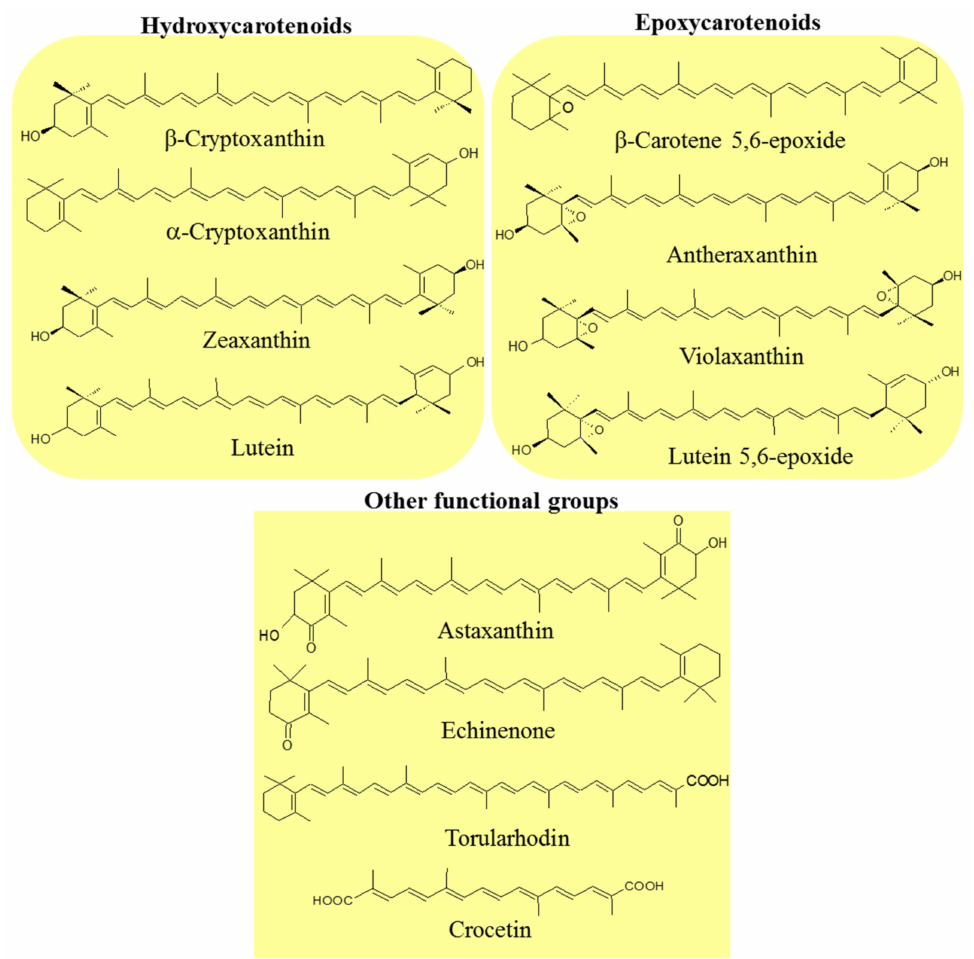
Figure 2. Examples of xanthophylls with some oxygenated functional groups in their structures: hydroxyl (hydrox- ycarotenoids), epoxy (expoxycarotenoids), ketone (astaxanthin and echinenone), and carboxylic acid (torularhodin and